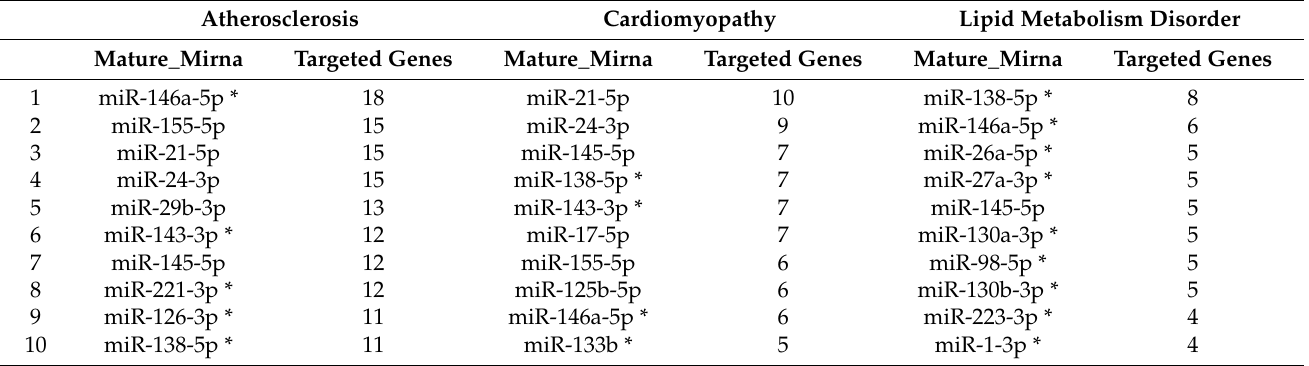
Figure 3. Network of VTGs enriched within the DOSE term arteriosclerosis. The network displays 160 arteriosclerosis-associated VTGs (circles in yellow), as well as 196 miRNAs (diamonds in purple), 17 SNPs (squares in turquoise) and 70 drugs (triangles in red) that are CVD-associated, and target and/or affect them. The network was created using Cytoscape [59]. Table 2. Top 10 miRNAs implicated in atherosclerosis, cardiomyopathy and lipid metabolism